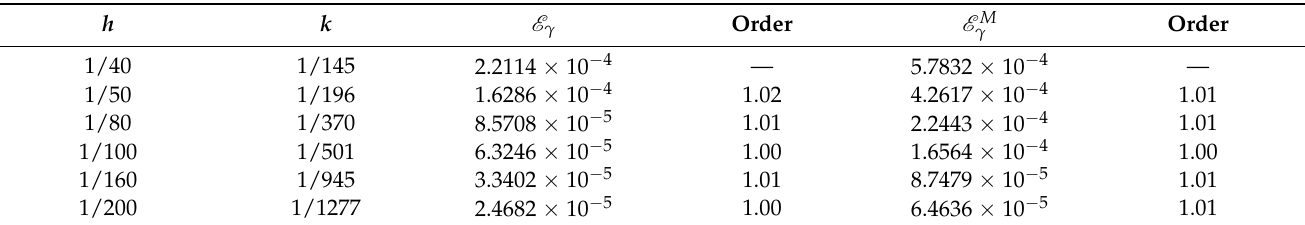
Table 7. E γ , E M γ and numerical convergence order in the temporal direction ( γ = 0.65, h ≈ k